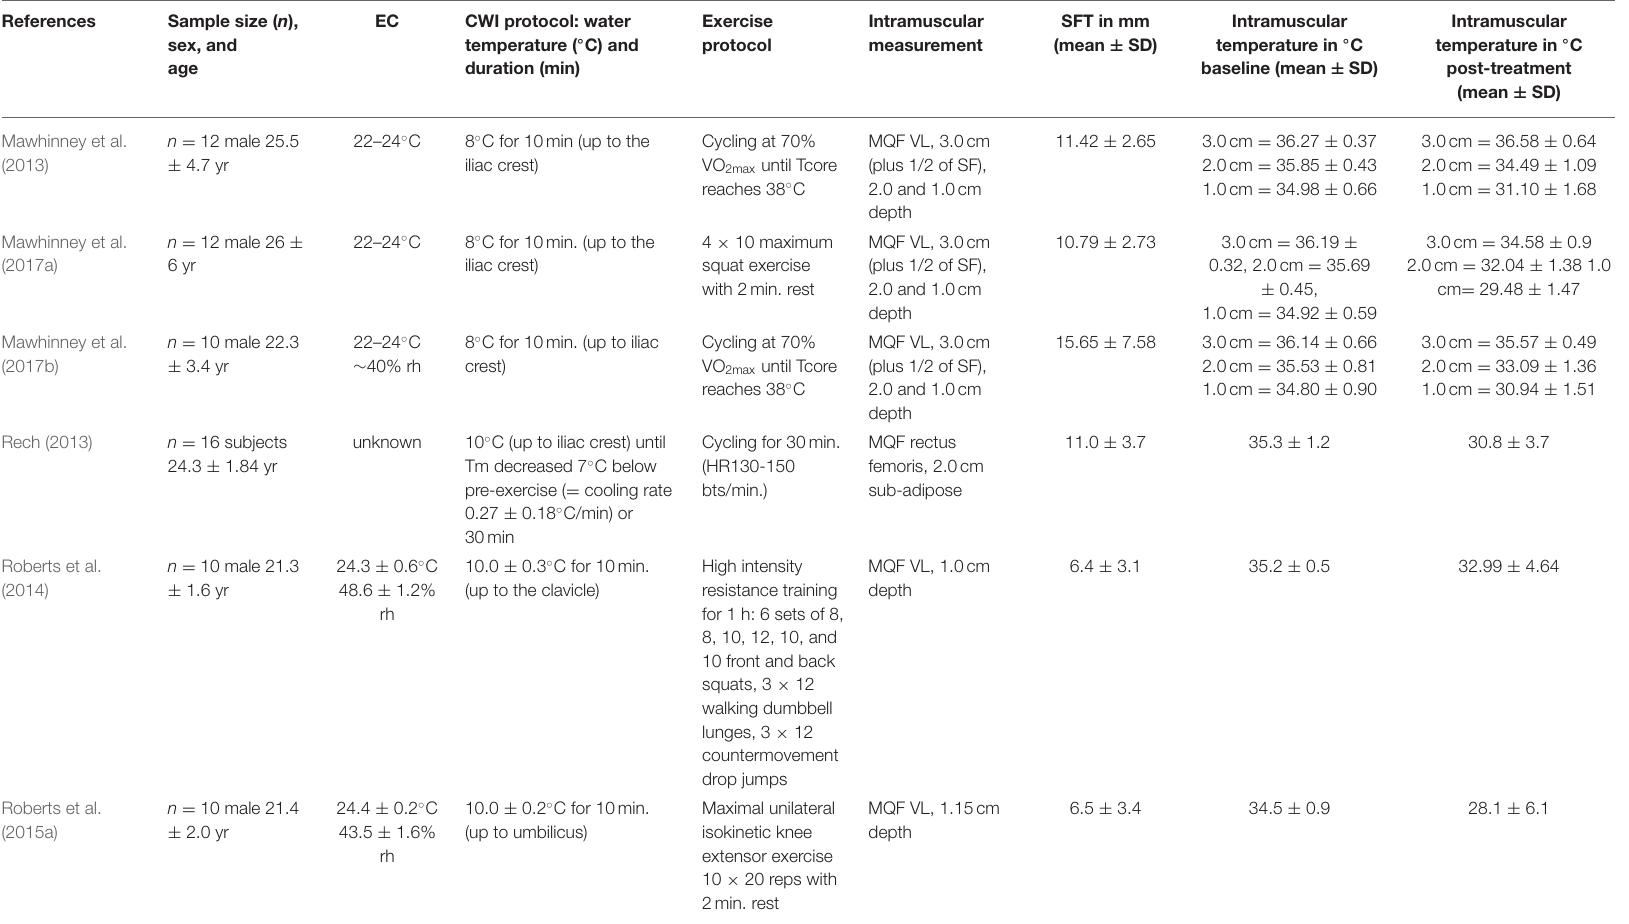
TABLE 2 | Summary of included